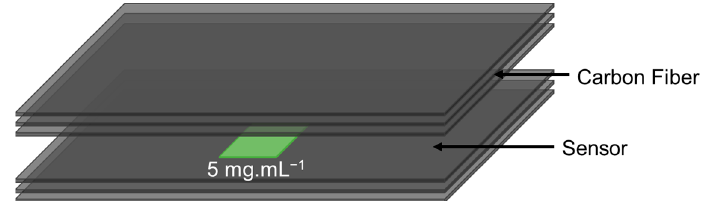
Figure 2. Schematic of the composite samples with embedded sensors for mechanical